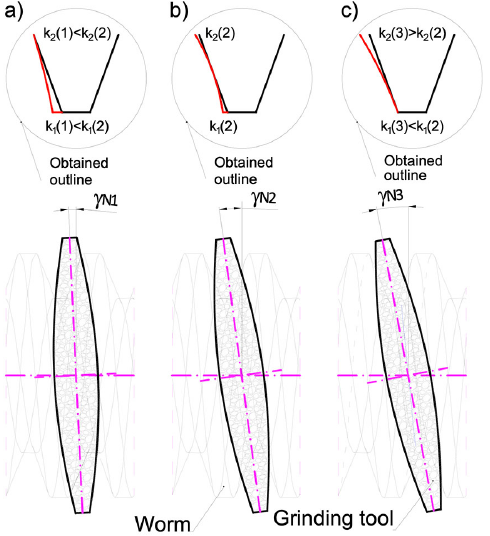
Figure 6. Causes of deviation from straightness of the axial outline of the helical surface; γ 1 , γ 2 , γ 3 —inclination angles of tangents to the helical surface outline on the diameter (in section I, II, III); γ N —inclination angle of the grinding wheel plane of symmetry.